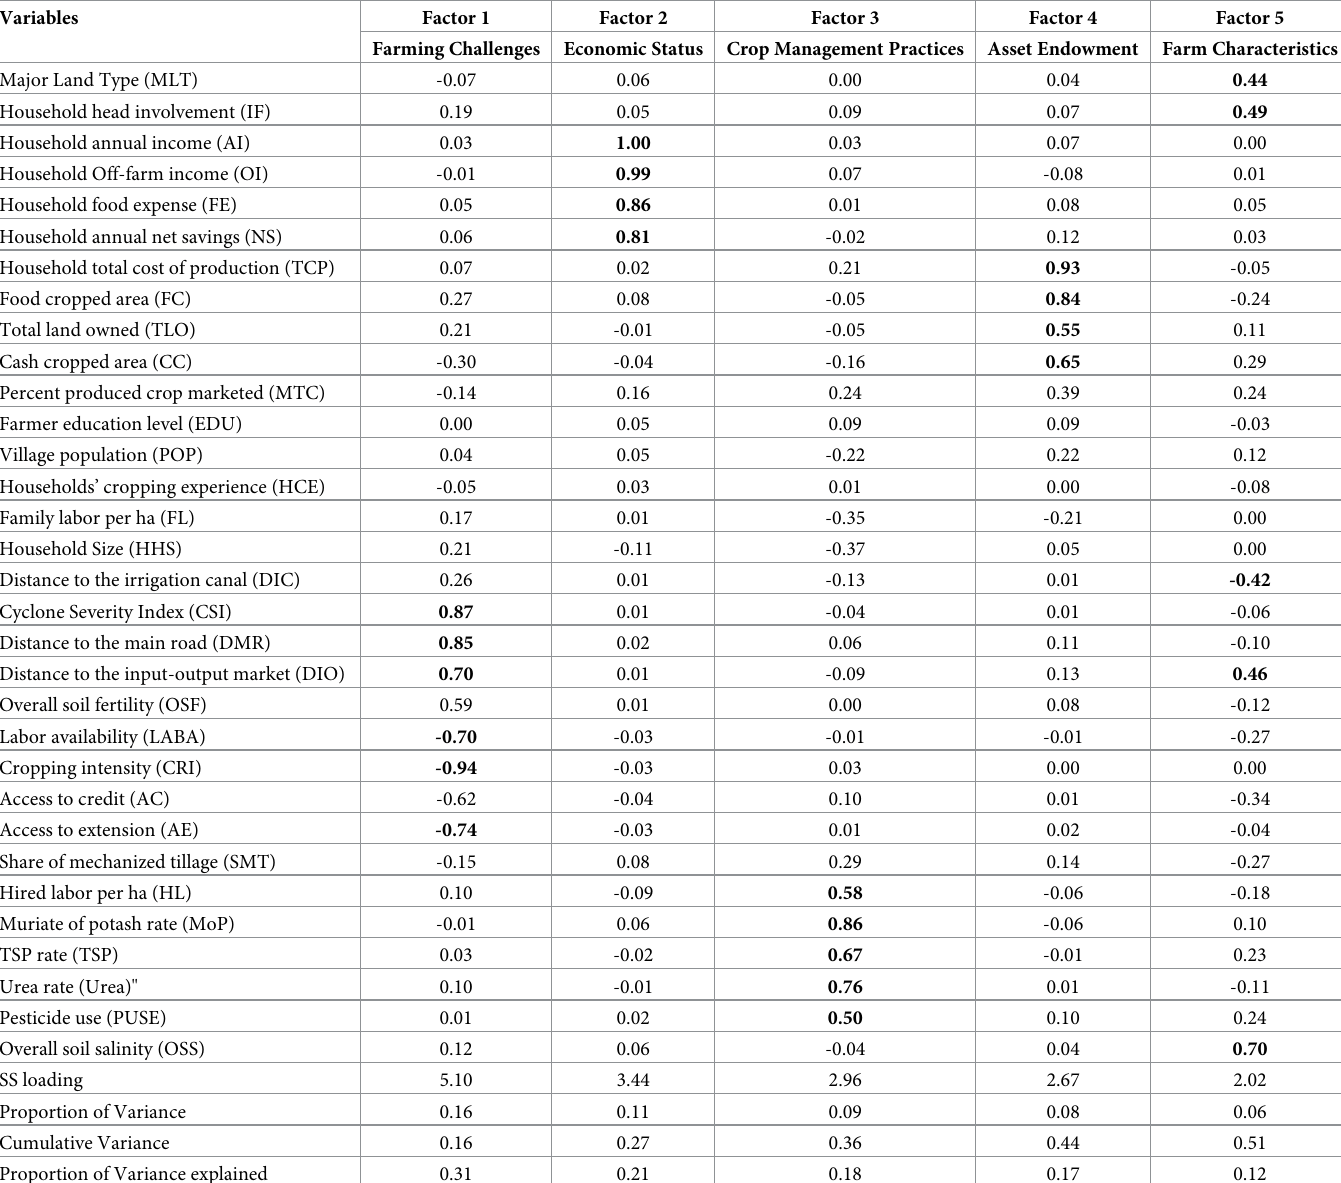
Table 2. Factors representing key differences in rice-based smallholder farming systems of coastal Bangladesh. Variables Factor 1 Factor